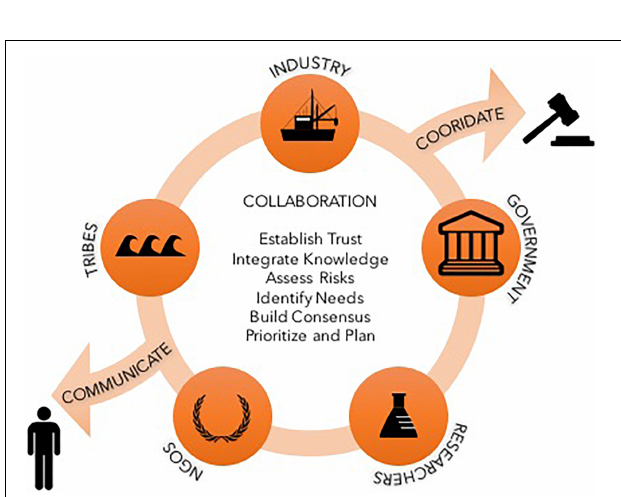
FIGURE 2 | Elements of successful coordination relationships exemplified by the Coastal Acidification Networks, and utilized by other networks profiled in these case studies. Successful CANs bring together diverse voices to establish trust, integrate knowledge, assess risks, identify needs, build consensus, and prioritize and plan responses to OA risks. Through these efforts, they can successfully communicate with the public and coordinate their efforts to efficiently advocate for specific